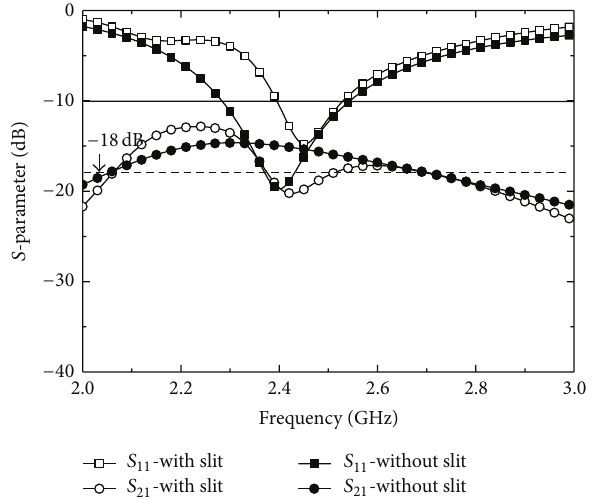
Figure 4: Simulated S -parameter results for the proposed antenna on the phantom with slit and without slit.